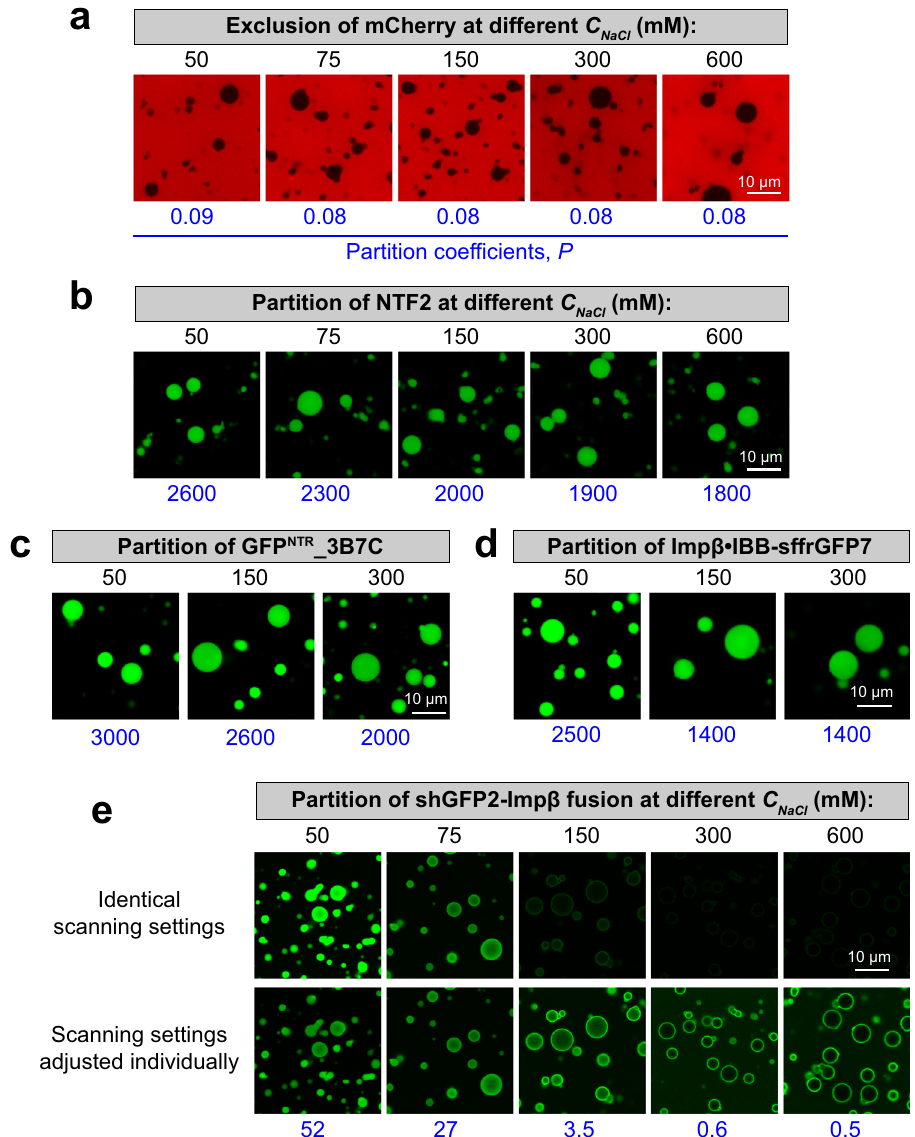
Fig. 8 | Permeation selectivity of FG phase at different strength of FG-FG cohesion. Partitioncoef fi cientsofdifferentpermeationprobesintointheFGphase formed by prf.GLFG 52×12 [+GLEBS] were measured at different indicated NaCl con- centrations ( C NaCl ), which modulate the strength of inter-FG cohesive interactions. These permeation probes include: an inert fl uorescent protein mCherry of 27kDa ( a ), NTF2 of 29kDa ( b ), which is covalently coupled with Alexa488 for tracking, a tetrameric 110kDa GFP NTR _3B7C variant ( c ), a 130kDa complex of Imp β and an FG- philic GFP variant sffrGFP7 containing an Imp β -binding (IBB) domain ( d ), and a